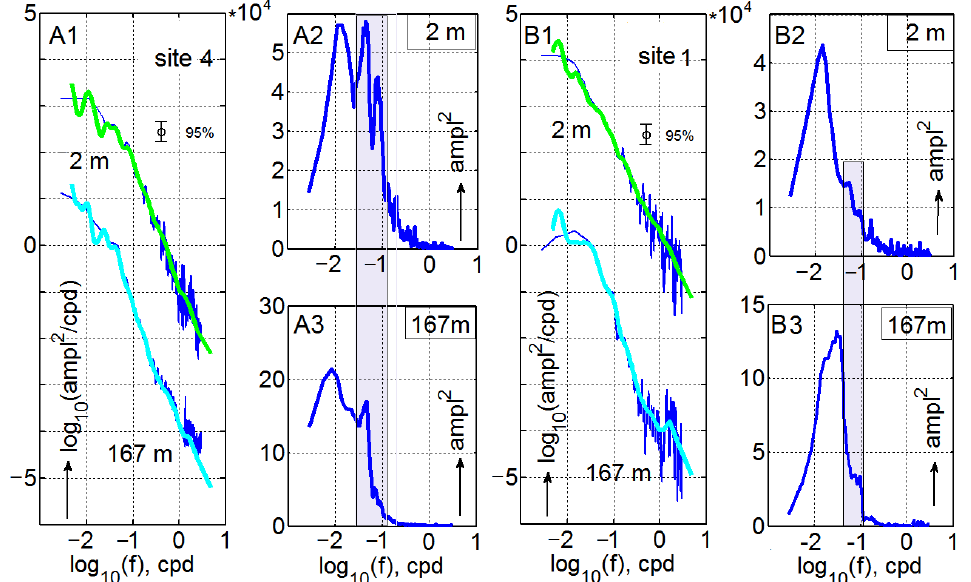
Figure 3. Spectra of kinetic energy, KE = 0.5 (U 2 + V 2 ) , at the continental slope (Site 4, panel A1 ) and shelf slope (Site 1, panel B1 ). In the panel ( A1 , B1 ) in log – log coordinates, thin blue curves denote Fourier spectral densities while thick light-green and light-blue curves denote the mean Fourier spectral densities at 2 m and 167 m, respectively; thick blue curves in semi-log coordinates denote variance-preserving spectra ( A2 , A3 , B2 , B3 ). Frequency range with high level of coherence is shaded. The variable “ampl” is in units of J/m 3 .